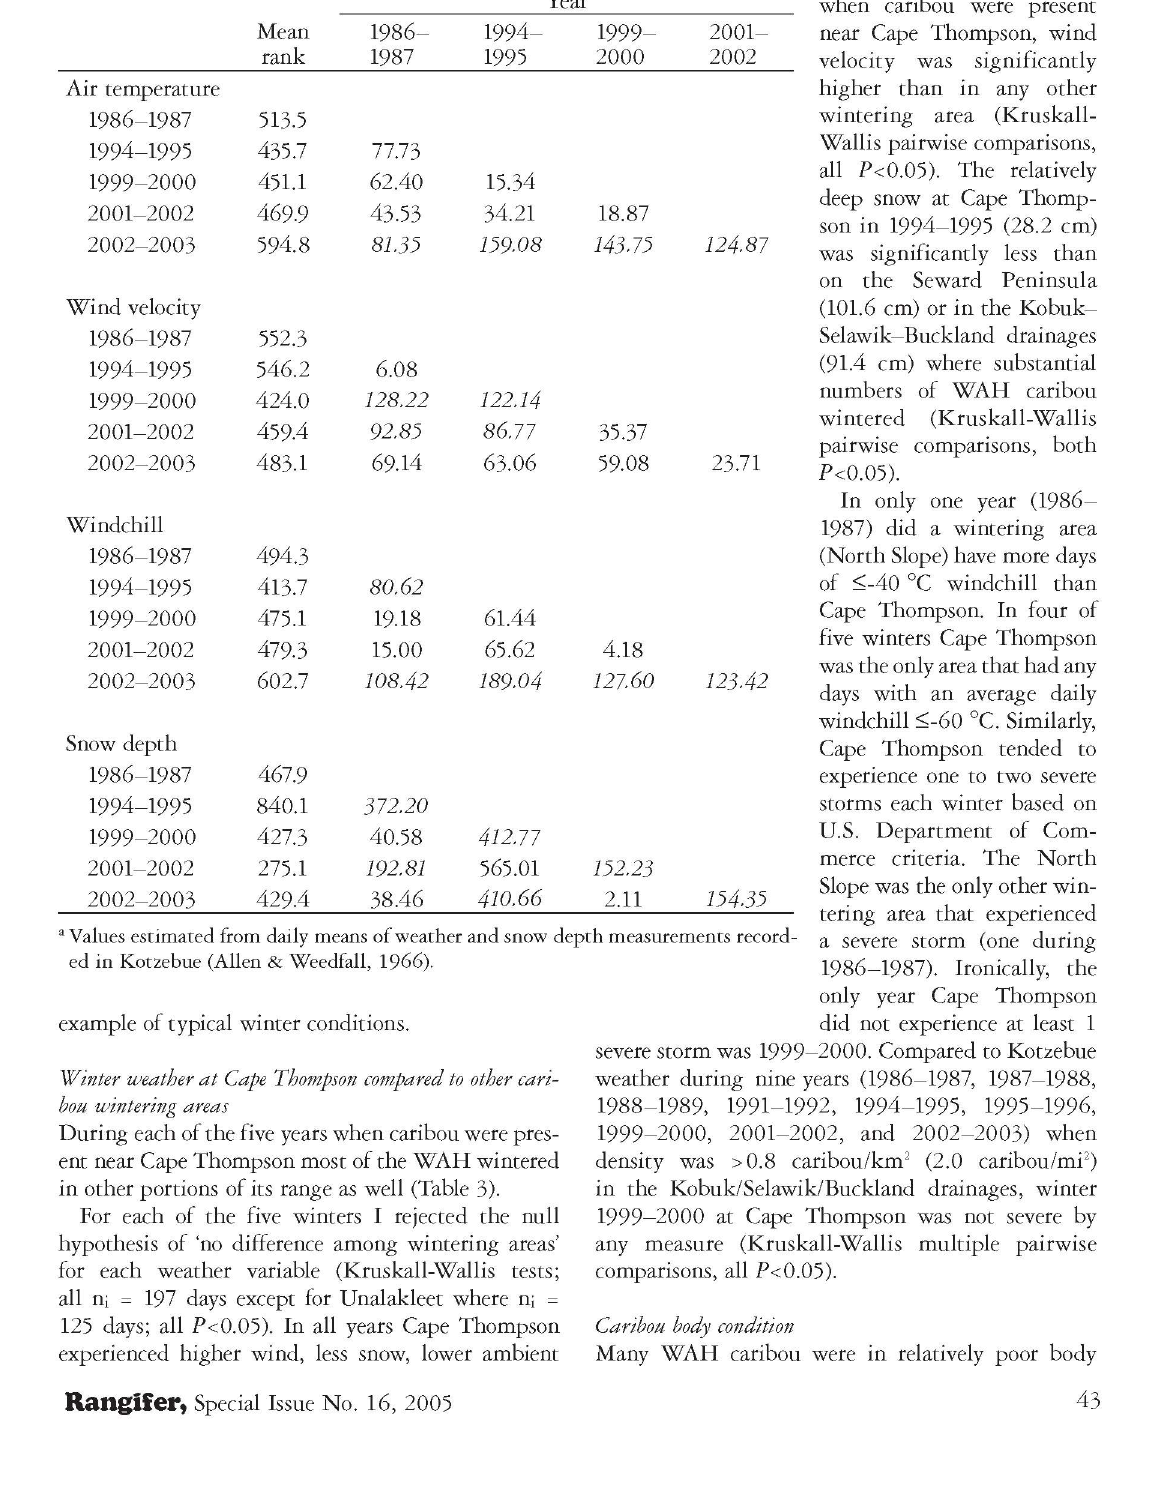
Table 2. Kruskall-Wallis test statistics for multiple pairwise comparisons of weather parameters estimated a for Cape Thompson during years when caribou wintered in this area; an italicized value indicates a statistically significant difference (all n = 197 days; all critical values = 80.46; all i